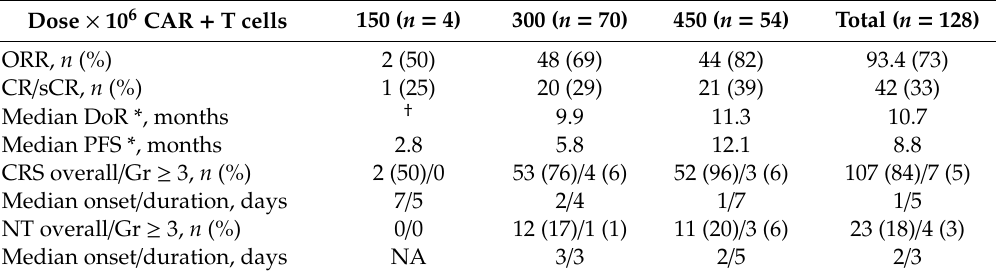
Table 3. E ffi cacy and safety data from the KarMMa